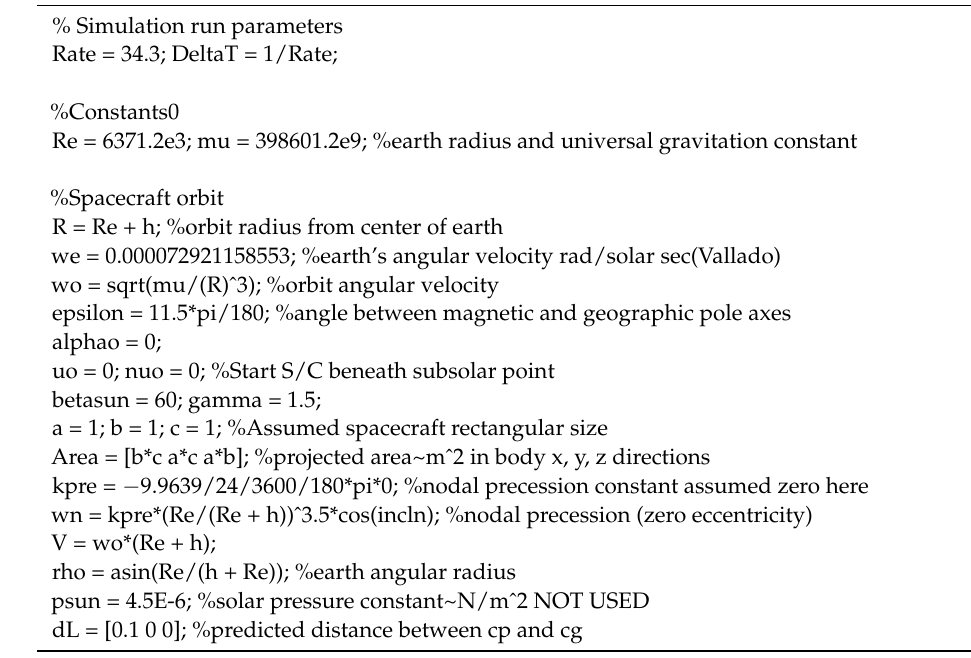
Figure A9. Kinematics subsystem in the Rotation block in Figure A1. Algorithm A1. InitFcn callbacks for SIMULINK model depicted in Figures 3–6